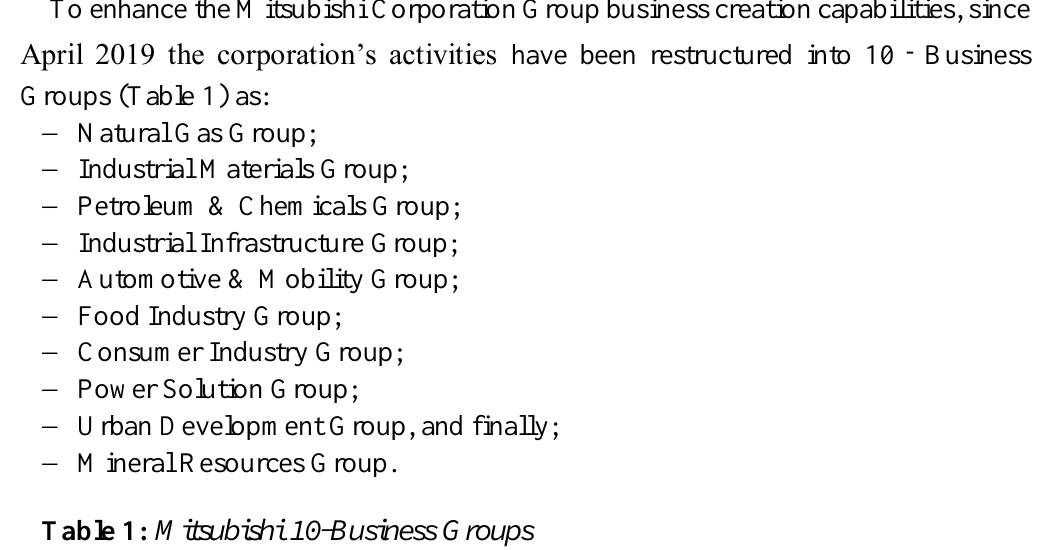
Table 1: Mitsubishi 10-Business Groups Natural Gas